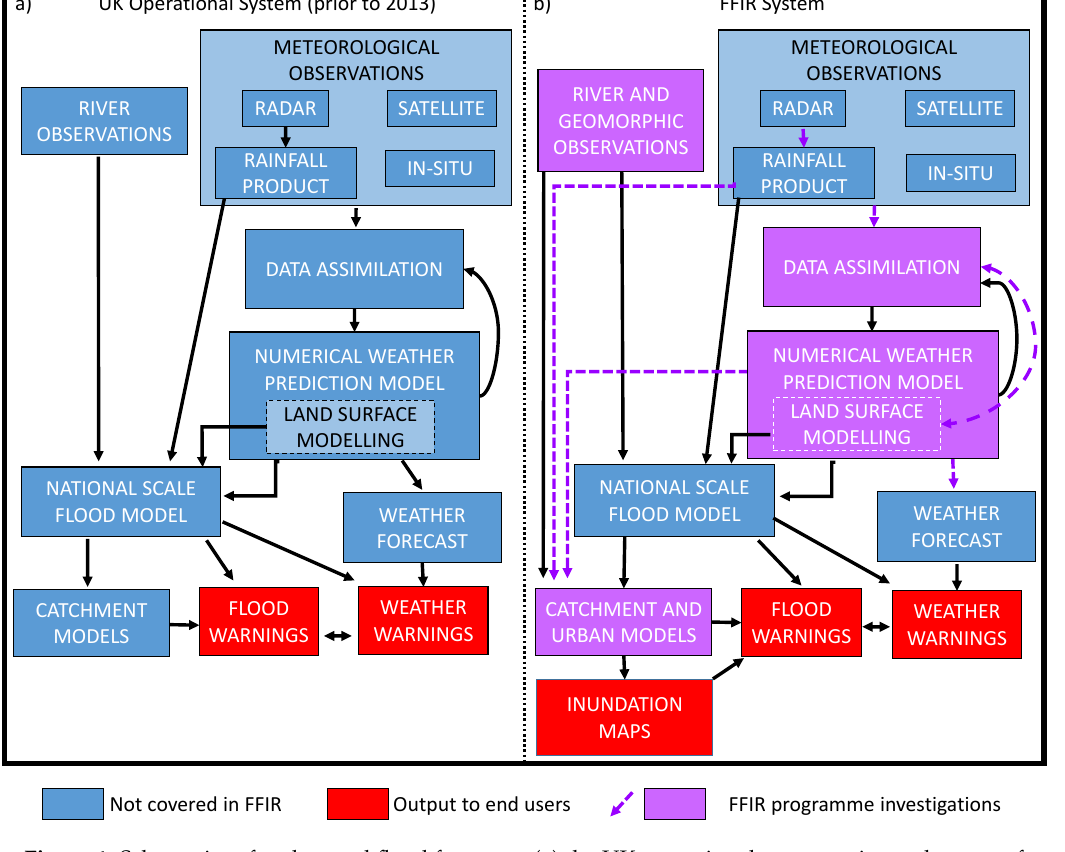
Figure 1. Schematics of end-to-end flood forecasts: ( a ) the UK operational system prior to the start of the FFIR (Flooding From Intense Rainfall) programme in 2013 and ( b ) the FFIR proposed vision for a national end-to-end forecast for flash and surface water flooding. Arrows represent the links between the different boxes. Purple items are those considered by the FFIR programme directly, blue (regardless of shade) boxes are the items that have not been directly researched/changed by the programme and red boxes indicate the output to the end user. The land-surface modelling is operationally run as part of the NWP (Numerical Weather Prediction) model so is thus included within that